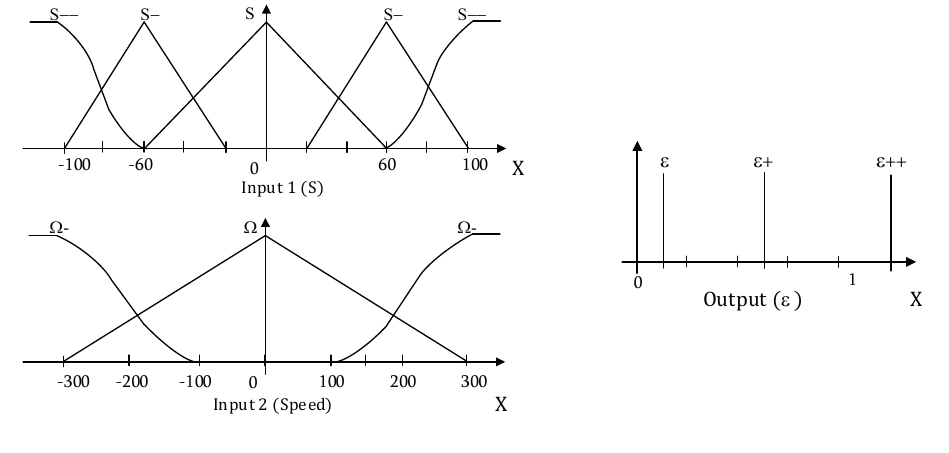
Figure 4. The proposed inputs and output sets. Table 1. Rules base of the fuzzy controller.